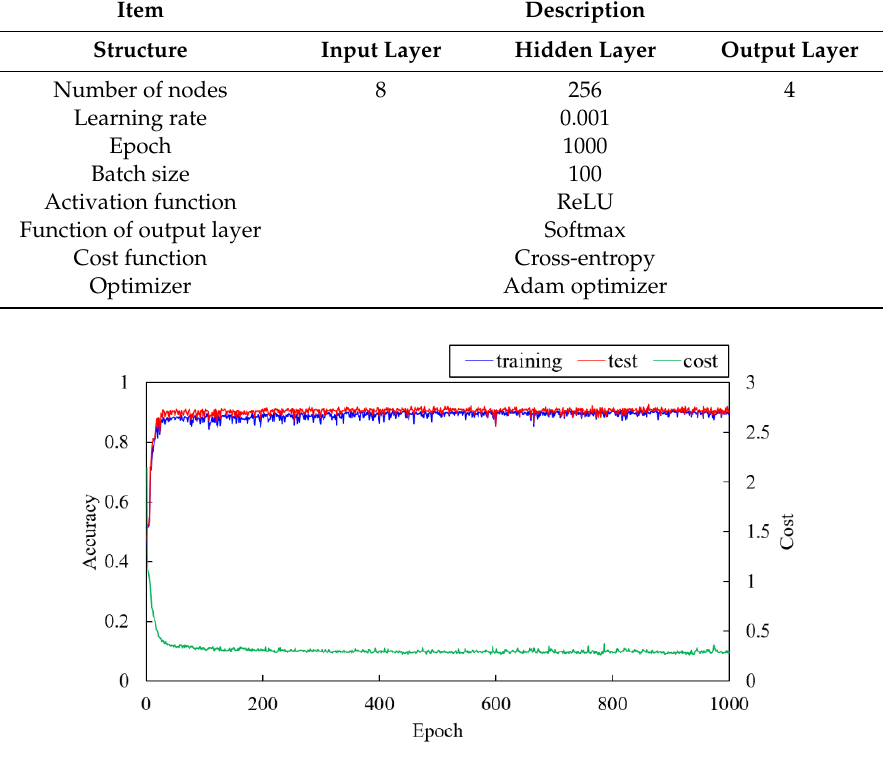
Figure 11. Training results: training accuracy, test accuracy, and cost.